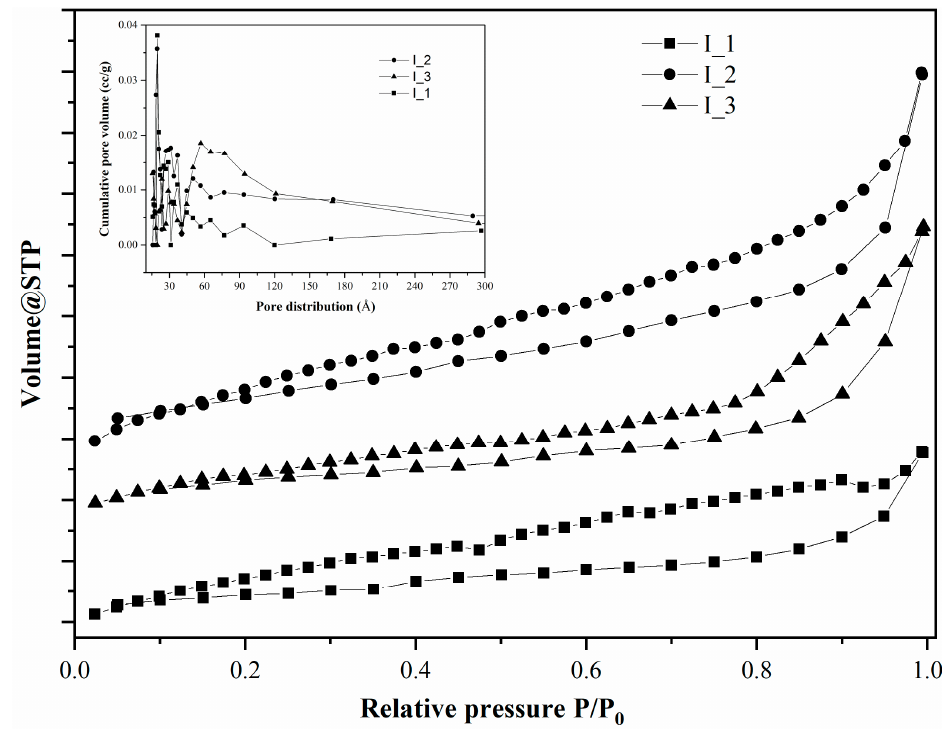
Figure 5. Adsorption isotherms and pore distribution of I_1, I_2 and I_3 samples.